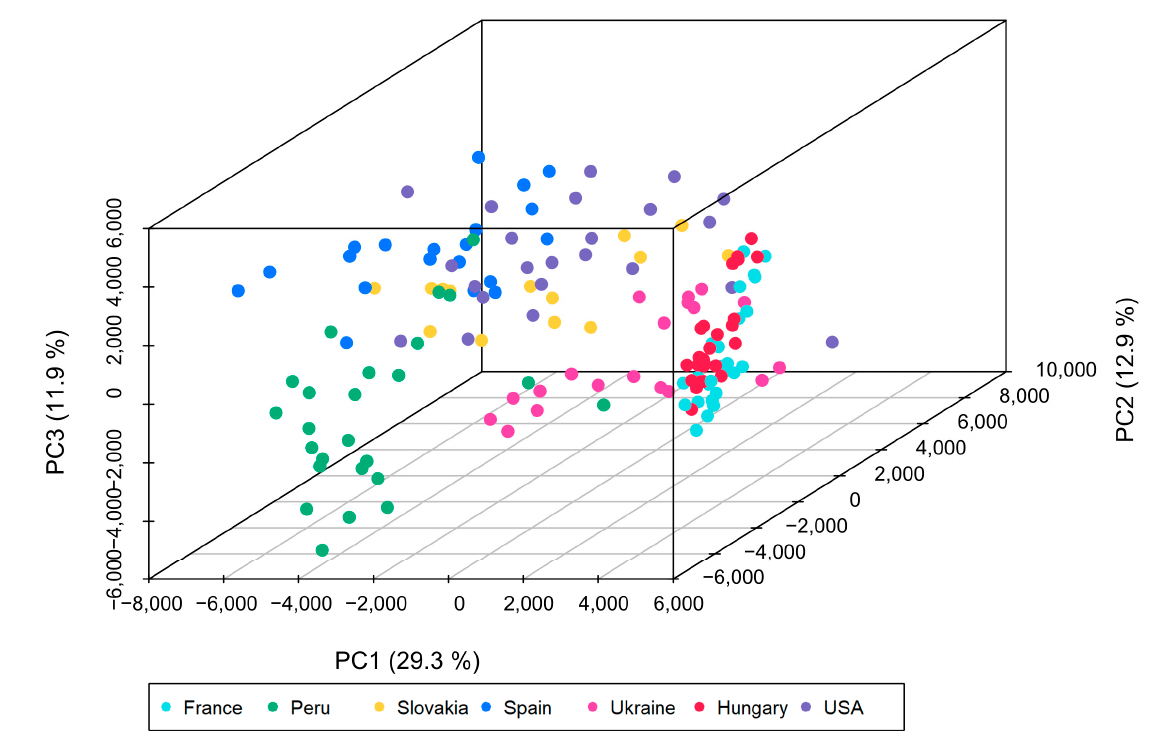
Figure 1. Principal component analysis (PCA) scores plot created using all features of the consensus peak table, after pareto scaling as preprocessing. The first three principal components (PC1-PC3) are displayed.